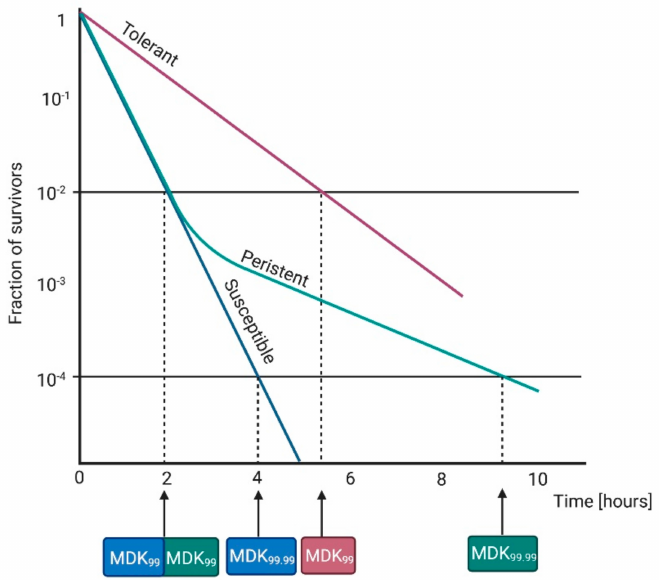
Figure 2. Characteristics of bacterial responses to light-based treatments. Minimum duration for killing 99% of bacterial cells (MDK 99 ) is substantially longer for tolerant than susceptible and persistent strains. MDK 99 for persistent and susceptible strains is similar, but MDK 99.99 for persistent strains is substantially higher than for susceptible strains. Time scale is chosen for illustration purposes only (modified from Brauner et